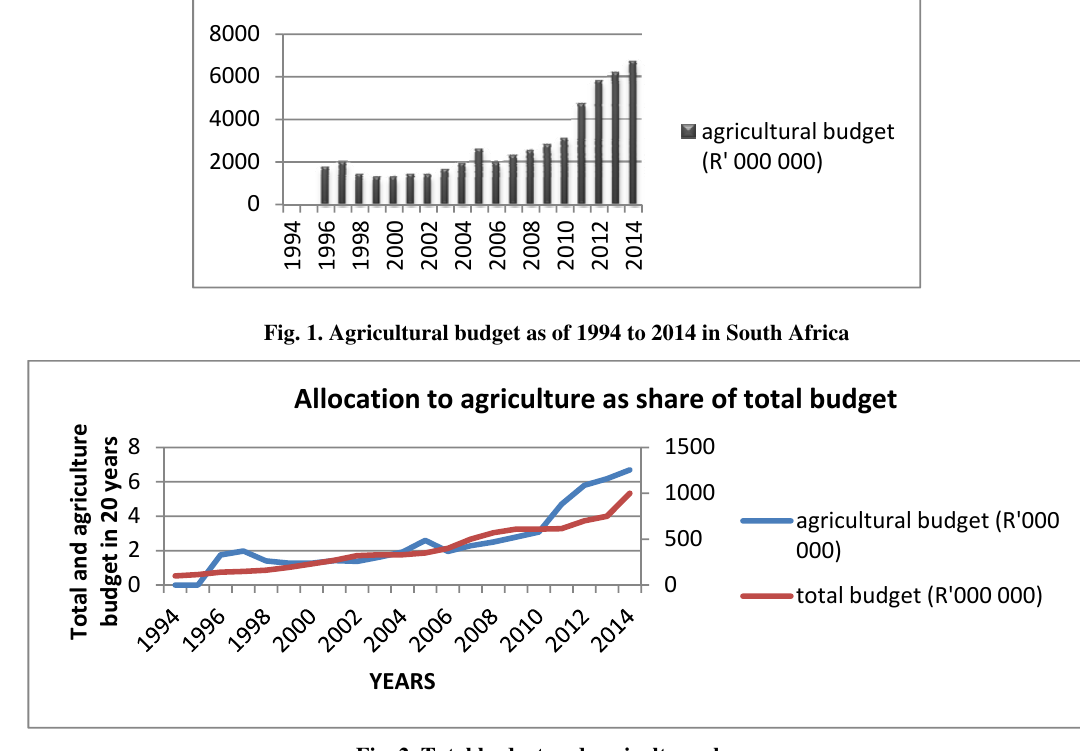
Fig. 2. Total budget and agriculture share